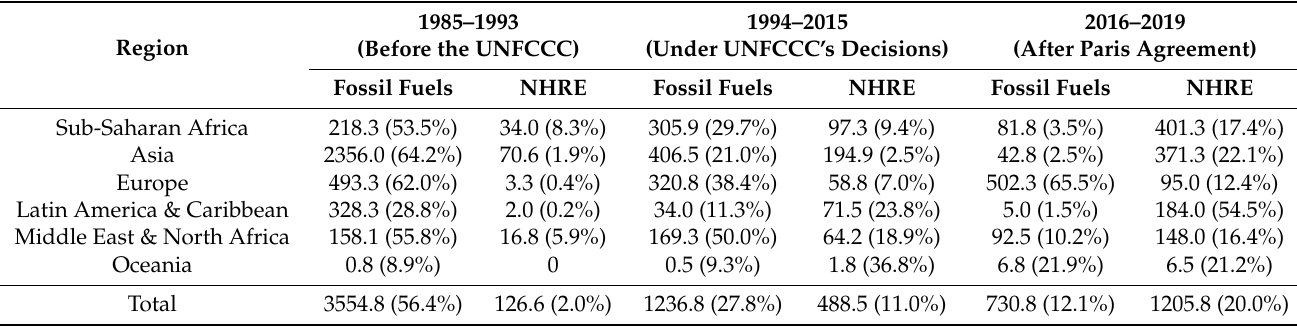
Table 7. Investments in fossil fuels and NHRE by region and period (annual average) (unit: 2019 US$ million).